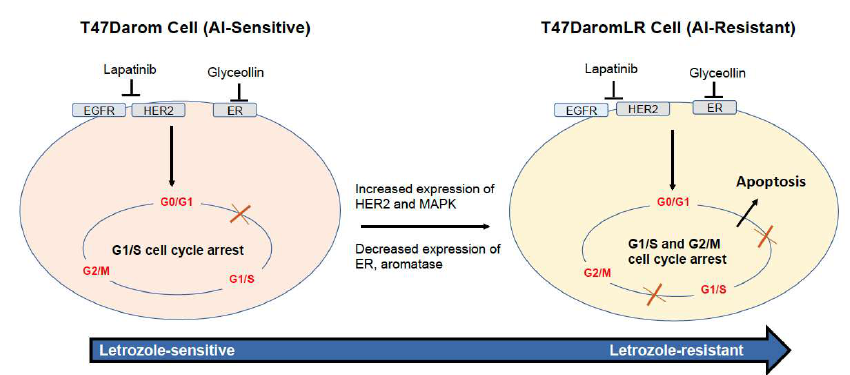
Figure 8. Schematic representing the glyceollin-induced inhibitory pathway in the T47DaromLR cell lines. Glyceollin blocks the ER while lapatinib blocks the EGFR and HER2 receptors leading to activation of caspase 3/7 activity, activation of pro-apoptotic proteins, and inhibition of anti-apoptotic proteins which leads to decreased proliferation and survival.